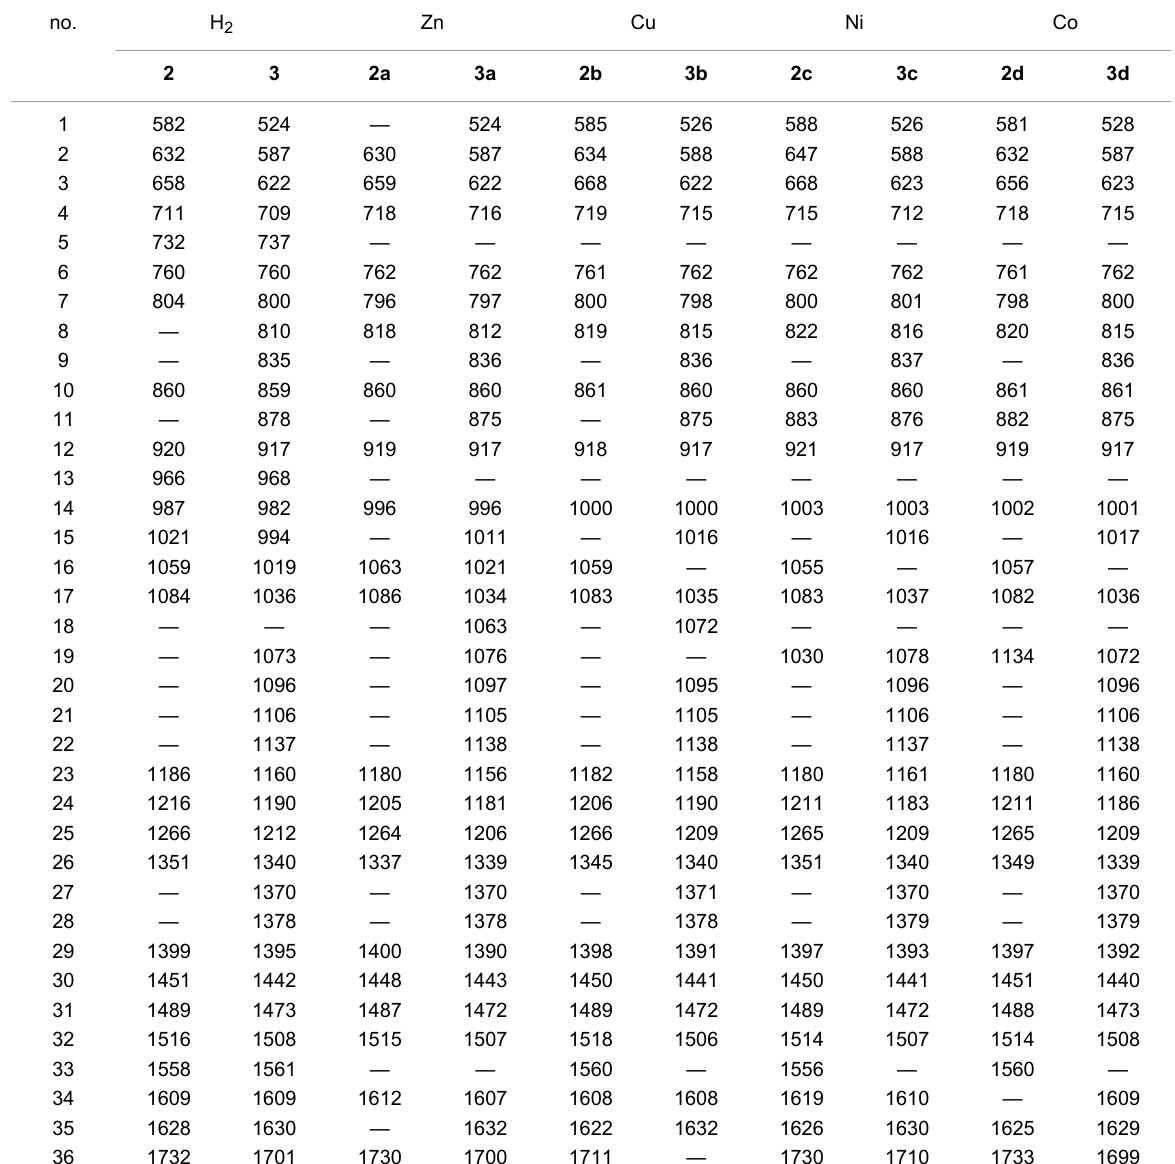
a cf. Figure 2 and Figure 3.